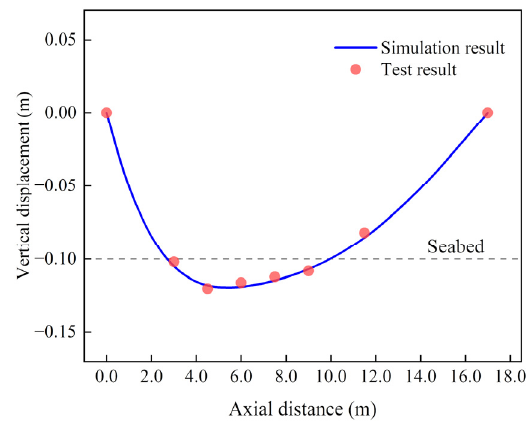
Figure 31. Developed vertical seabed